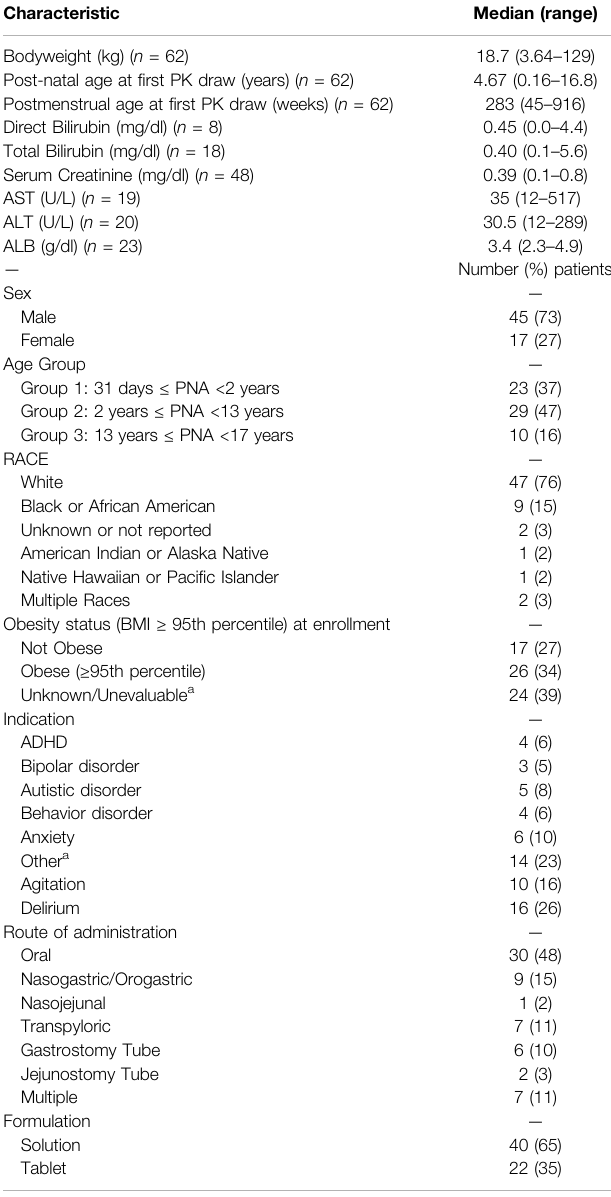
TABLE 1 | Population demographics and clinical characteristics of the patients in the external evaluation dataset. Characteristic Median